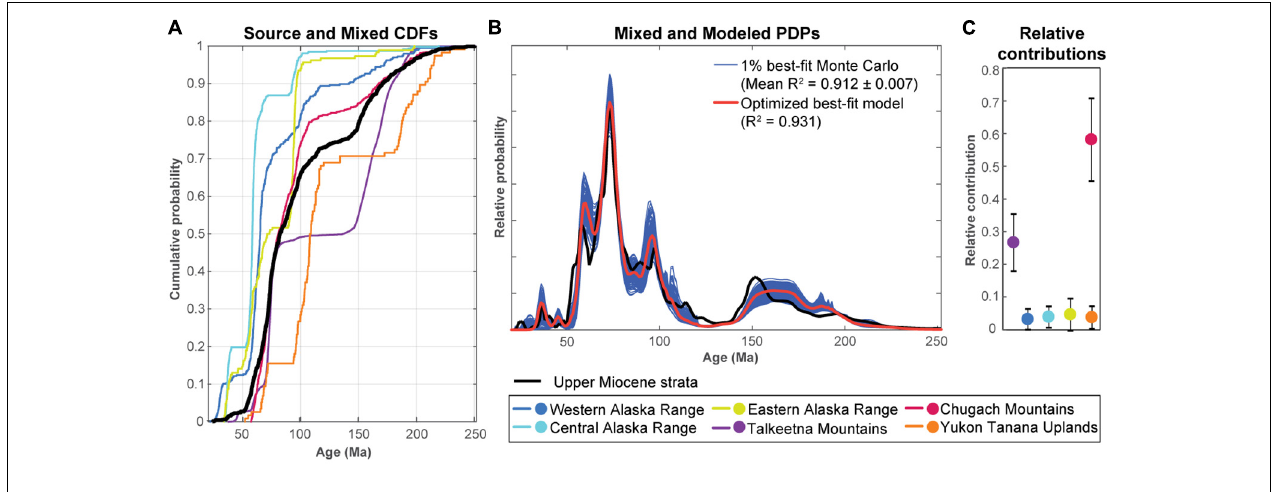
FIGURE 8 | Same as Figure 3 except for the Upper Miocene strata.